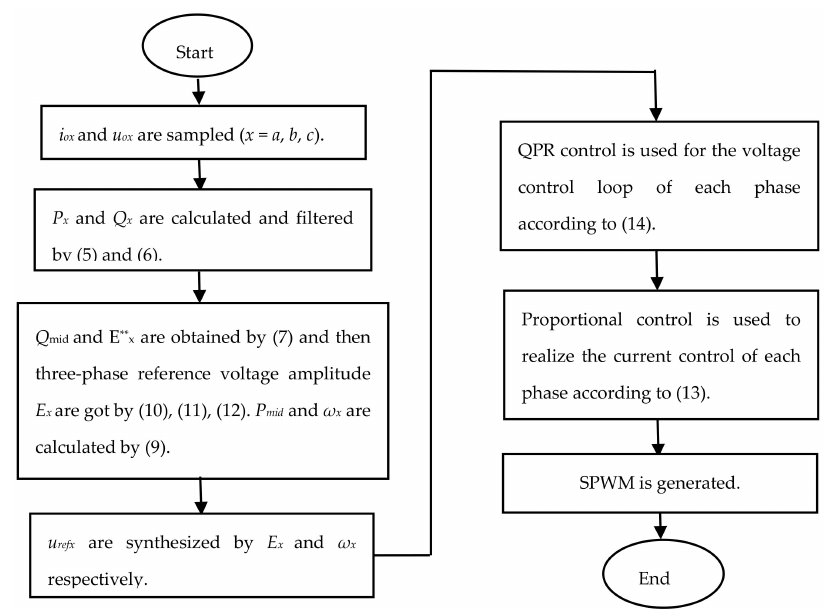
Figure 7. Flowchart of the designed control scheme.